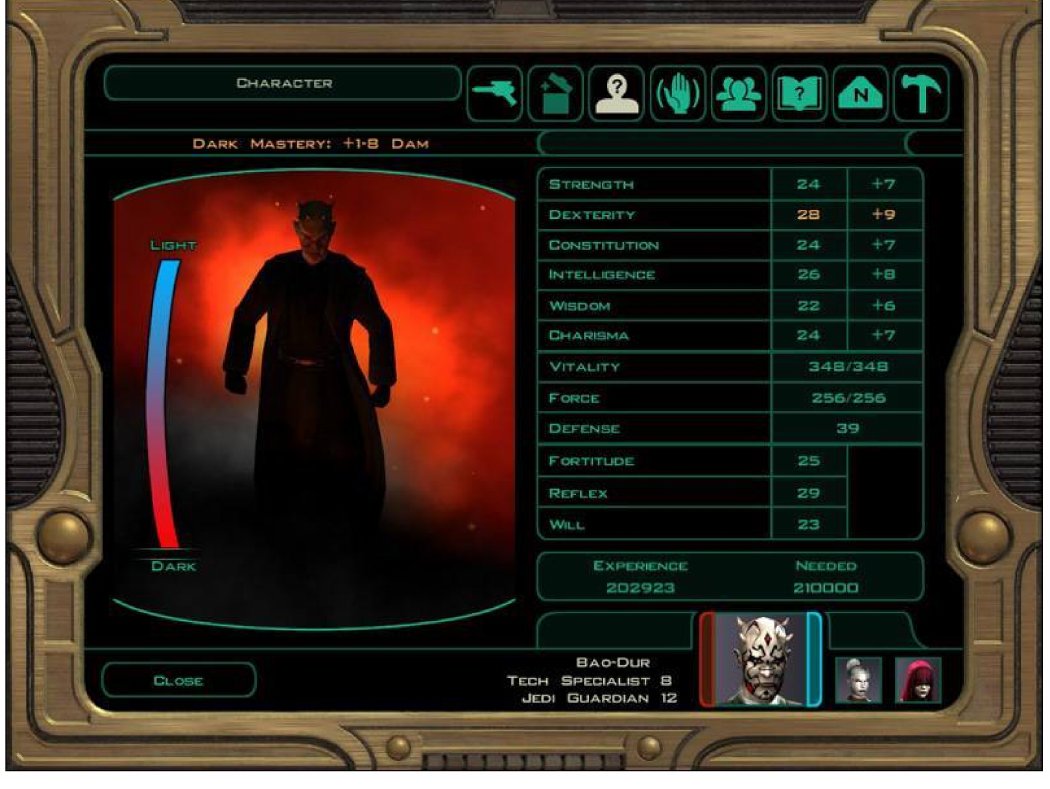
Figure 1. “Alignment” Bar 11